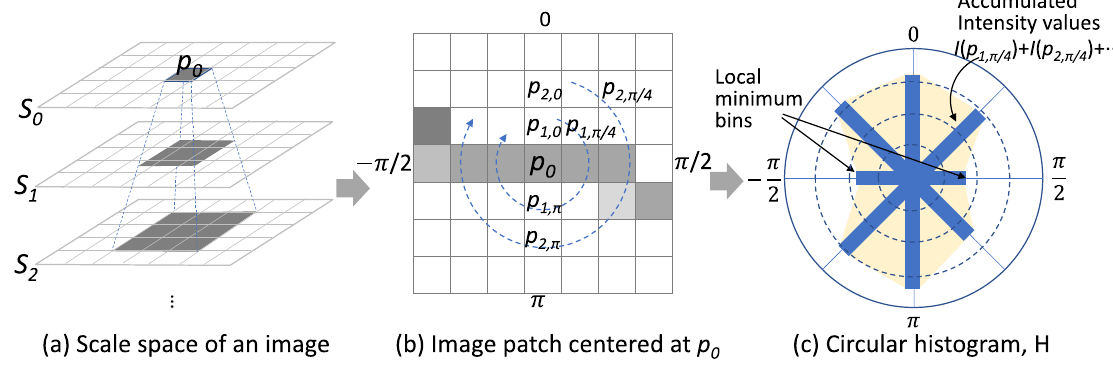
Figure 8. Detection of a crack pixel using an orientation histogram.